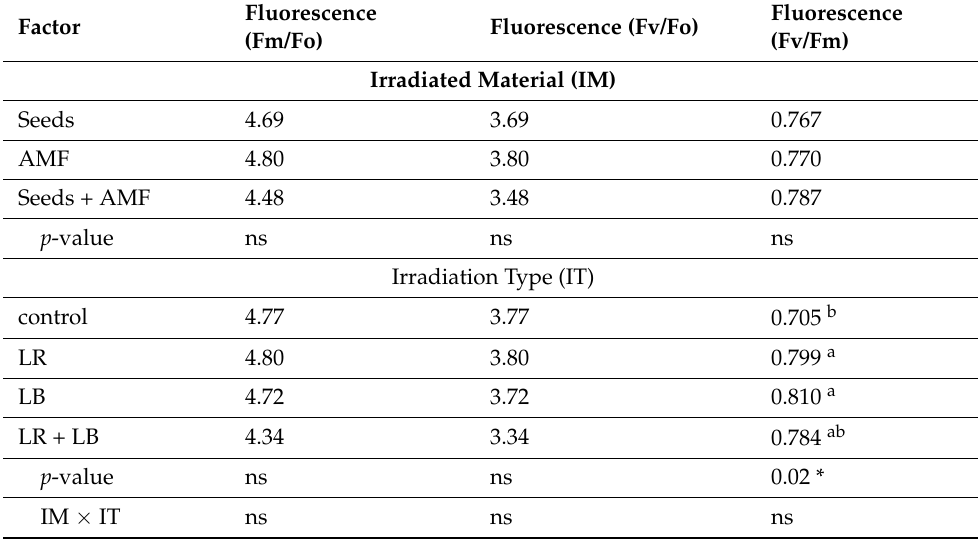
Table 2. Effect of irradiation stimulation on the fluorescence